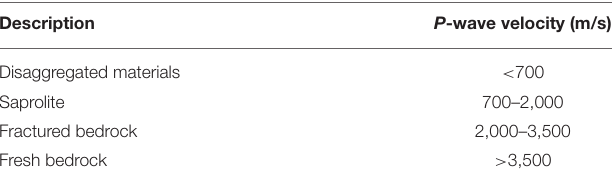
TABLE 2 | Mean depth and standard deviation of the mean to fractured and fresh bedrock measured at each seismic line and